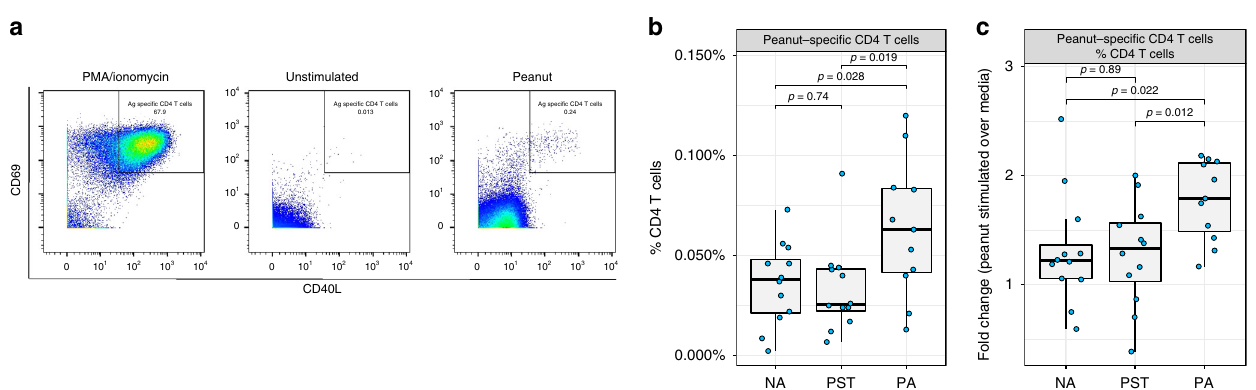
Fig. 5 Analysis of manually gated peanut-speci fi c CD4 T cells shows signi fi cant differences between peanut-sensitized tolerant (PST) and peanut- allergic (PA) infants. a Peanut-speci fi c CD4 T cells were identi fi ed in peanut-stimulated cultures based on upregulation and co-expression of T-cell activation markers CD40L and CD69. The positive control, PMA/ionomycin stimulation, was used to set the gates to identify these peanut-activated T cells in all groups. Peanut-speci fi c CD4 T cells were identi fi ed in PA infants ( n = 11), PST infants ( n = 12), and NA infants ( n = 12), and expressed as ( b ) proportion of CD4 T cells and ( c ) fold change after peanut stimulation over unstimulated (media) conditions. P -values by F-tests in linear models. In the boxplots, the medians are shown. The “ hinges ” represent the fi rst and third quartile. The whiskers are the smallest and largest values after exclusion of outliers (greater than the 75th percentile plus 1.5 times the IQR, or less than 25th percentile minus 1.5 times the IQR). Source data are provided as a Source Data fi